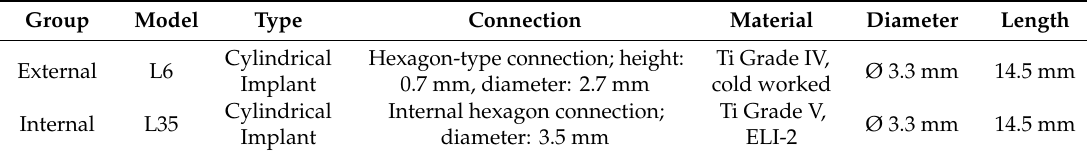
Figure 1. Schematic representation of the implants studied (L6, Oxtein, Spain, external connection, ( a ); L35, Oxtein, Spain, internal connection, ( b )). Table 1. Representation of the characteristics of the different implants studied.